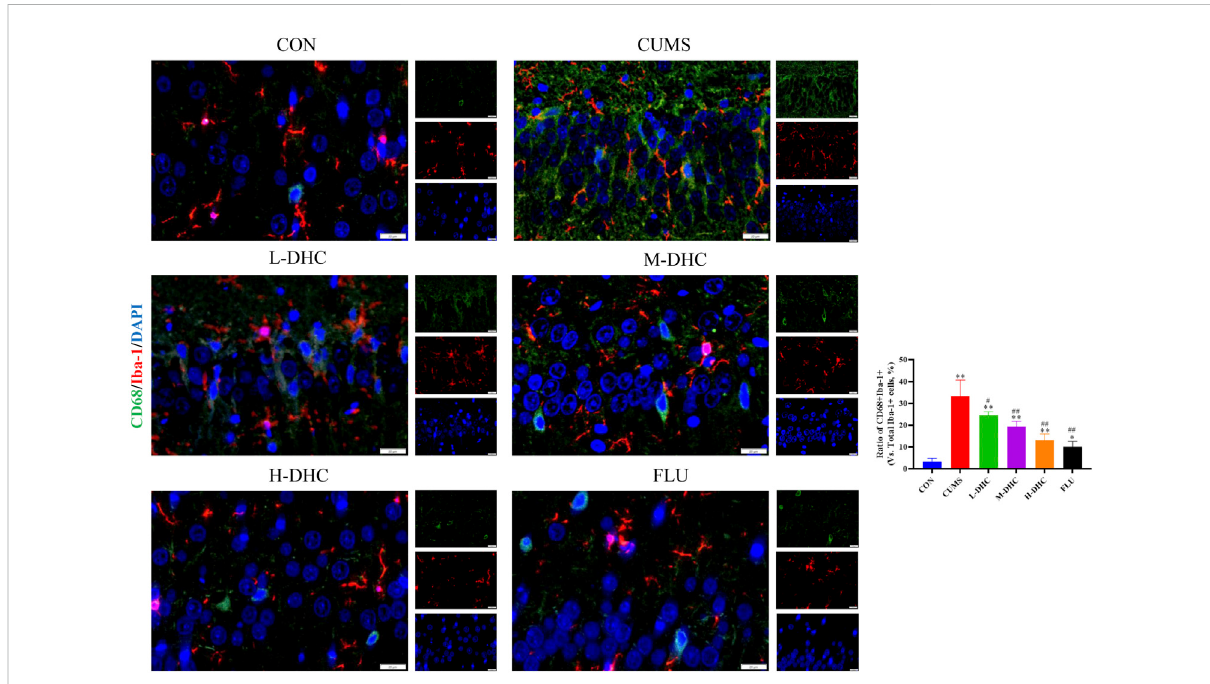
FIGURE 8 Effects of DHC or fl uoxetine on microglia activation in CUMS-induced depression in mice. Red fl uorescence represented Iba-1 positive cells, and green fl uorescence represented CD68 positive cells. ** p < 0.01, compared with the control (CON) group; ## p < 0.01, compared with the CUMS